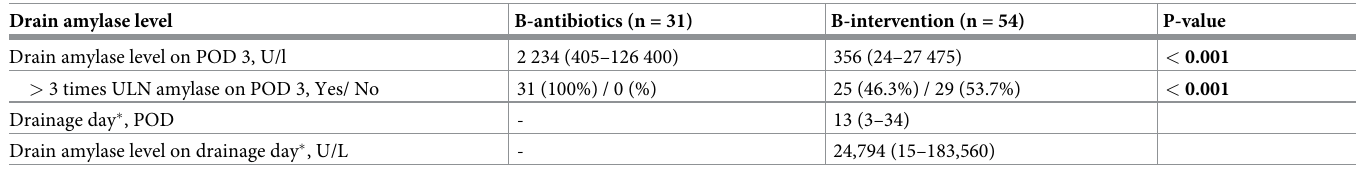
Table 5. Drain amylase level in grade B postoperative pancreatic fistula patients. Drain amylase